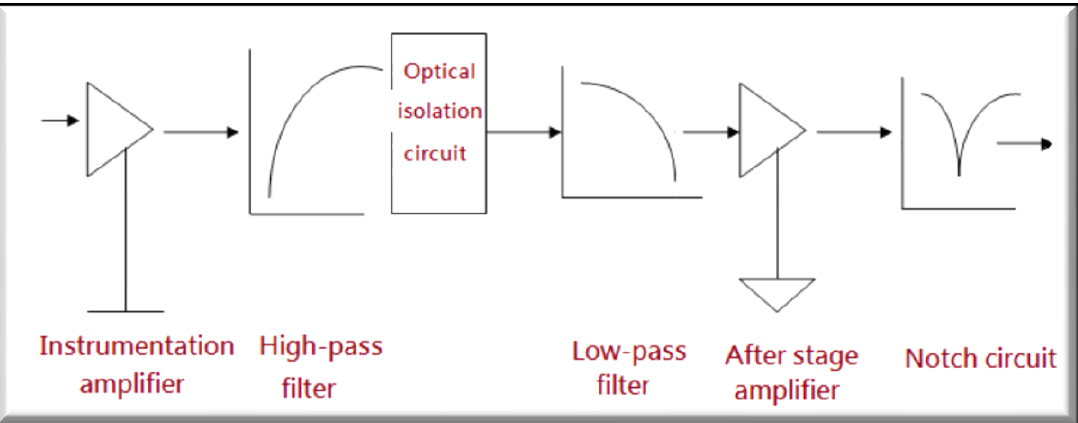
Figure 3. A schematic block diagram for an EEG